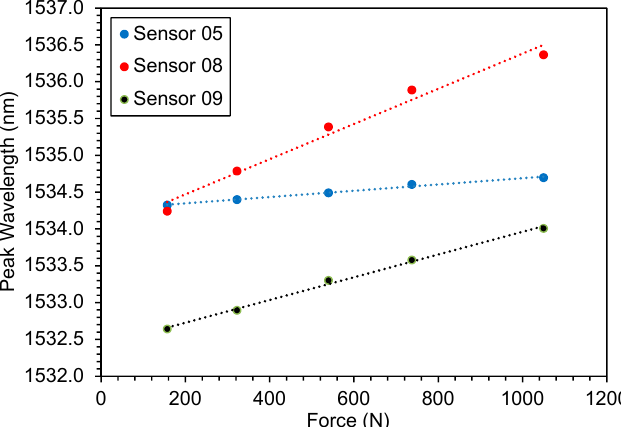
Figure 11. FBG peak wavelength curve as a function of the free fall height of the weight thrown against sensors S05, S08 and S09.